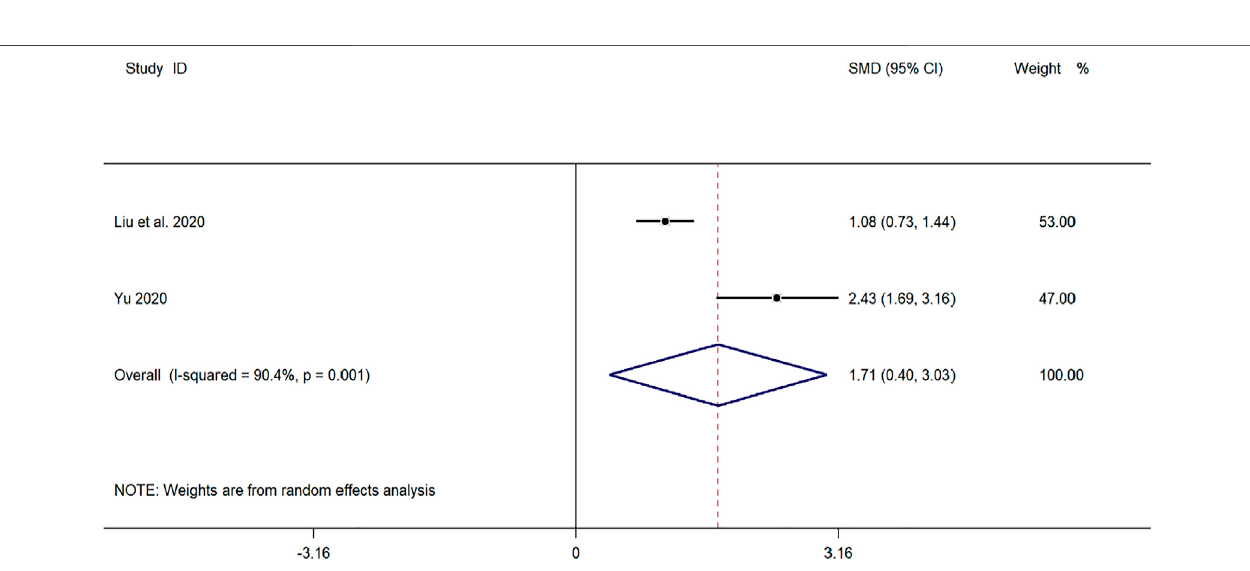
Frontiers in Pharmacology |